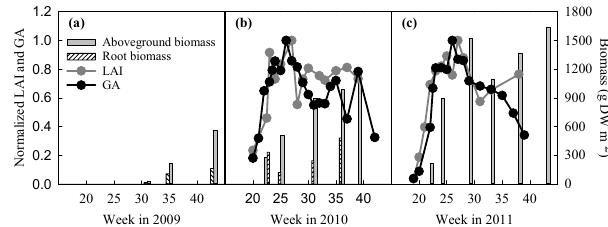
Figure 2. Vegetation parameters determined on the reed ca- nary grass (RCG) cultivation. Approximately monthly determined above-ground (grey bars) and root biomass (hatched bars) in gdryweight (DW) m − 2 between week 15 and 45 in (a) 2009, (b) 2010 and (c) 2011. Also approximately weekly determined nor- malized green area index (GA, black dots) and leaf area index (LAI, grey dots) for (b) 2010 and (c) 2011 is